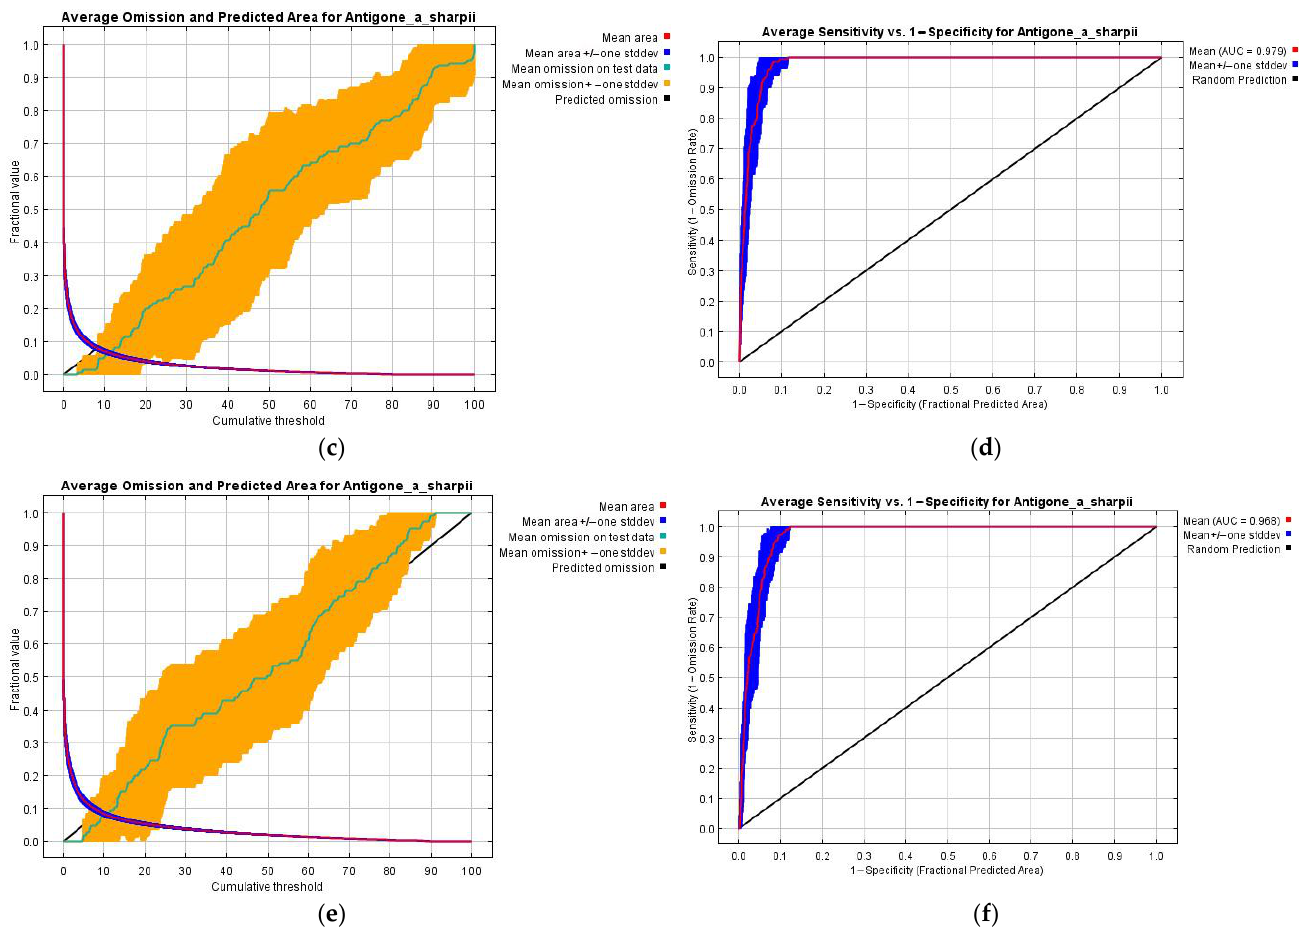
Figure 5. Average omission and predicted areas in ( a ) the summer season, ( c ) the rainy season, and ( e ) the winter season; and average sensitivity vs. 1 — specificity in ( b ) the summer season, ( d ) the rainy season, and ( f ) the winter season for eastern sarus cranes ( Antigone antigone sharpii ) in Ayeyarwady Delta, the Union of Myanmar. Table 2. MaxEnt special distribution model output for training area under curve (AUC), test gain, and test AUC for eastern sarus crane ( Antigone antigone sharpii ) in the Ayeyarwady Delta in the summer season, the rainy season, and the winter season in Ayeyarwady Delta, the Union of Myan- mar.